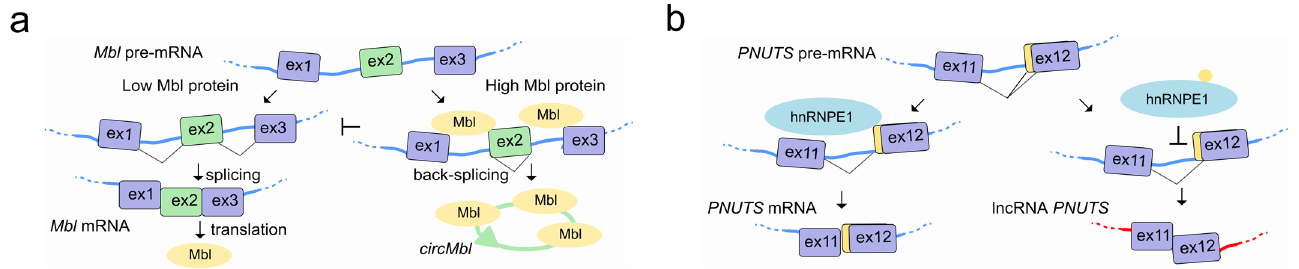
Figure 6. LncRNAs regulate pre-mRNA splicing by competing for splicing factors during their own splicing. ( a ) Left, In the presence of low amounts of Mbl (orange), the Mbl transcript is canonically spliced into a translatable mRNA encoding the Mbl protein. Right, when Mbl levels are high, Mbl binds to the pre-mRNA at the intronic regions flanking exon 2 and causes the exon2 back-splicing into circMbl (green), thereby preventing linear splicing and translation of the Mbl protein. CircMbl can also sequester Mbl protein, lowering its free cellular concentration, thereby providing a feedback mechanism to regulate Mbl levels. ( b ) The PNUTS gene can encode either the PNUTS mRNA or the lncRNA PNUTS depending on the usage of the 3’ alternative splice site located at the 5’-end of exon 12 which leads to the change of the ORF and the generation of a premature stop codon. Left, upon the binding of hnRNP E1 to a BAT consensus element located in the alternative splicing site that mask and prevents its usage, PNUTS pre-mRNA is spliced into PNUTS mRNA then translated into the PNUTS protein. Right, loss of hnRNP E1 binding to the alternative splice site uncovers the consensus element and allows its usage by the spliceosome machinery to achieve the splicing to yield the lncRNA PNUTS transcript.